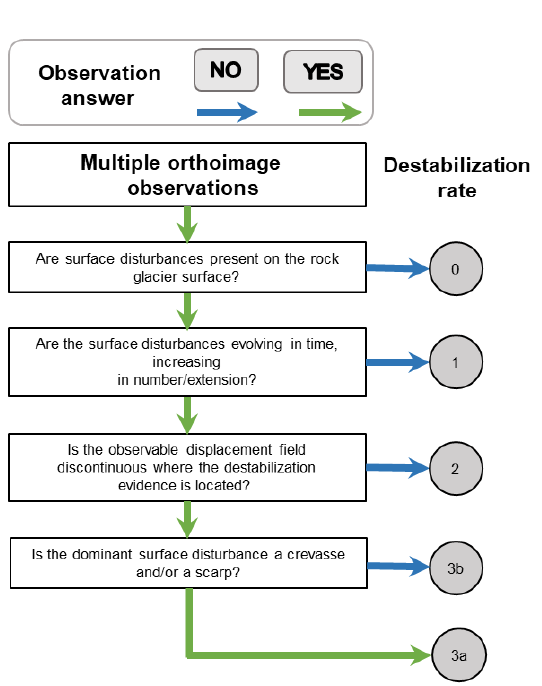
Figure 4. General pipeline used to rate rock glacier destabiliza- tion by observing surface disturbances and the qualitative displace- ment field. Higher destabilization ratings indicate potentially unsta- ble rock glaciers, while lower ratings indicate stable rock